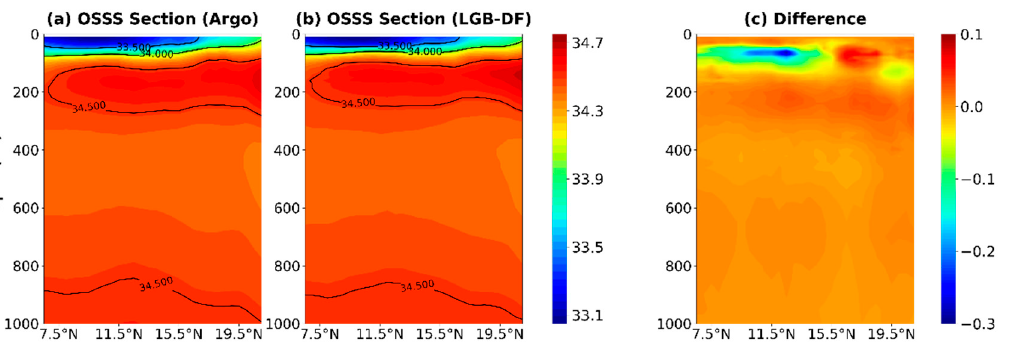
Figure 11. Argo-observed OSSS, LGB-DF-estimated OSSS and the differences between them, along a transect passing through the SCS from southwest to northeast. The black contours are, from top to bottom, 33.5 psu, 34.0 psu, and 34.5 psu, respectively.